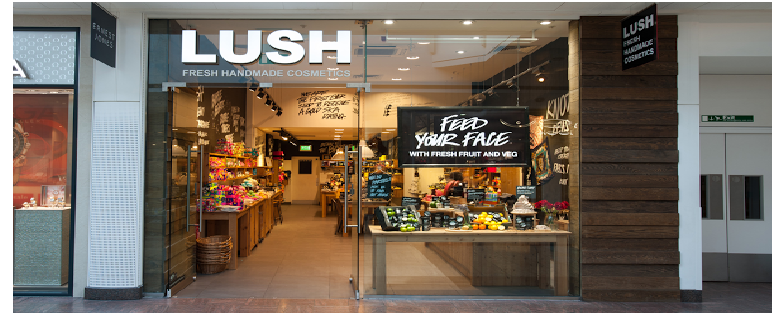
Figure 4. Elevated display window style.